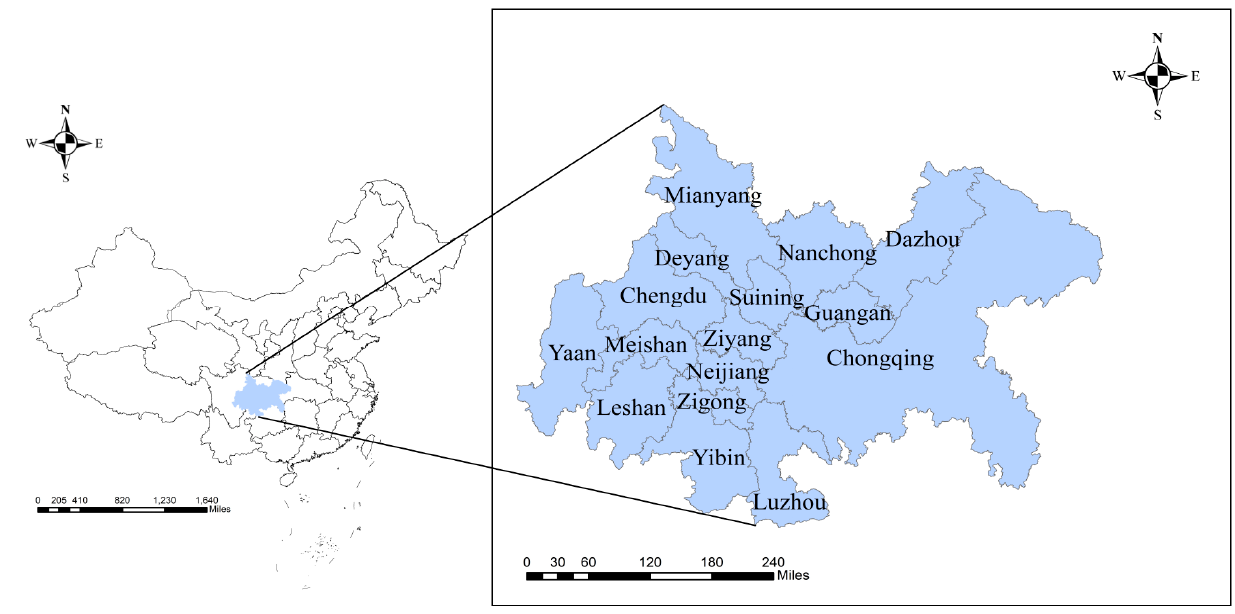
Figure 1. Study area.